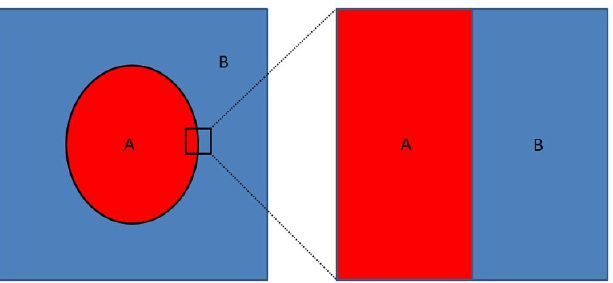
Figure 3 . For the charge sector, we can apply the Bisognano-Wichmann result to a generic partition by zooming in on a small patch (which looks locally planar), then summing the contributions from all such